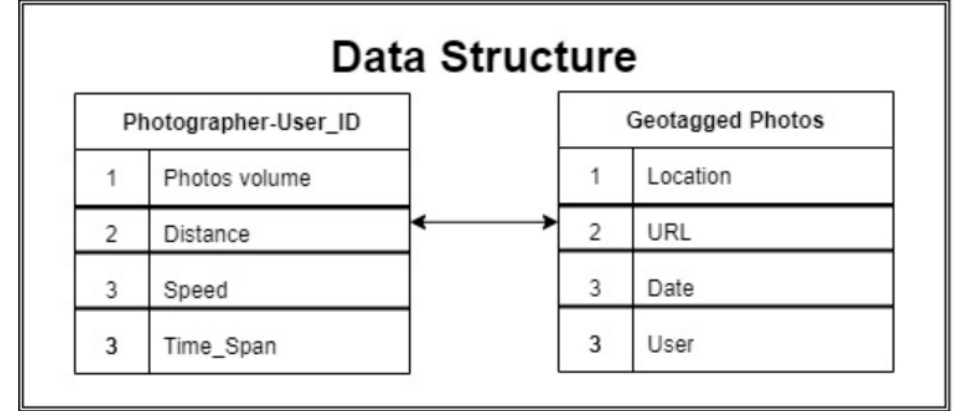
Figure 2. Data structure linking a photographer and her or his geotagged photos.